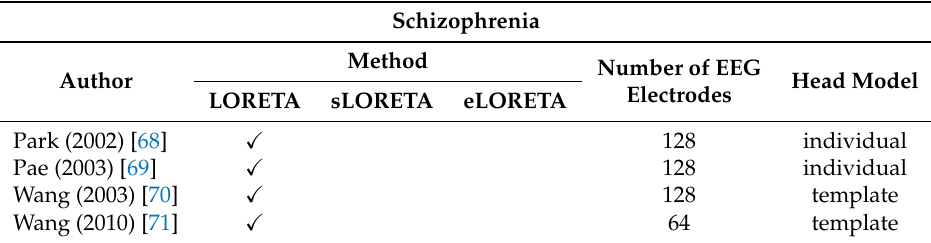
Table 6. Overview of the included papers about